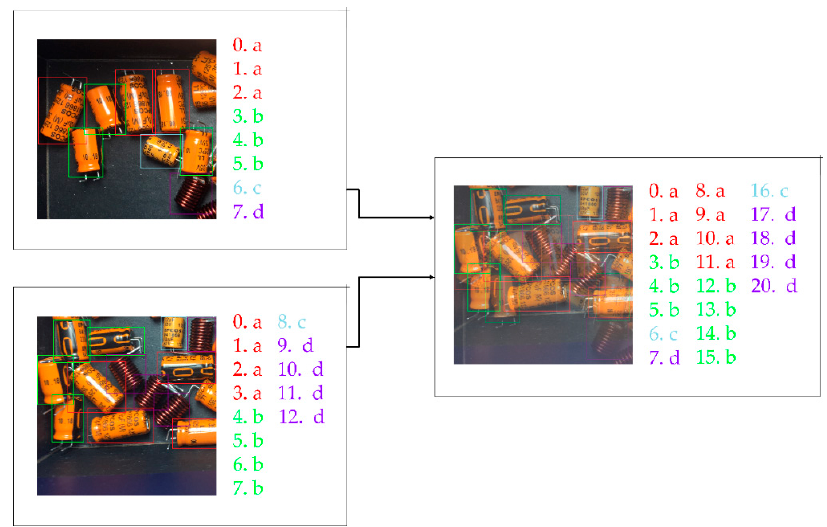
Figure 7. Mixup method for object detection. Image pixels are blended and object labels are merged to generated new image.